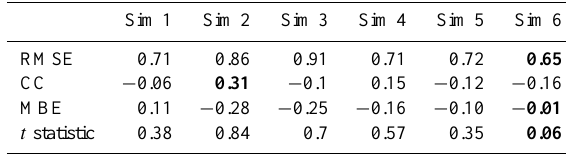
Table 2. Statistical evaluation of different simulations for SST.